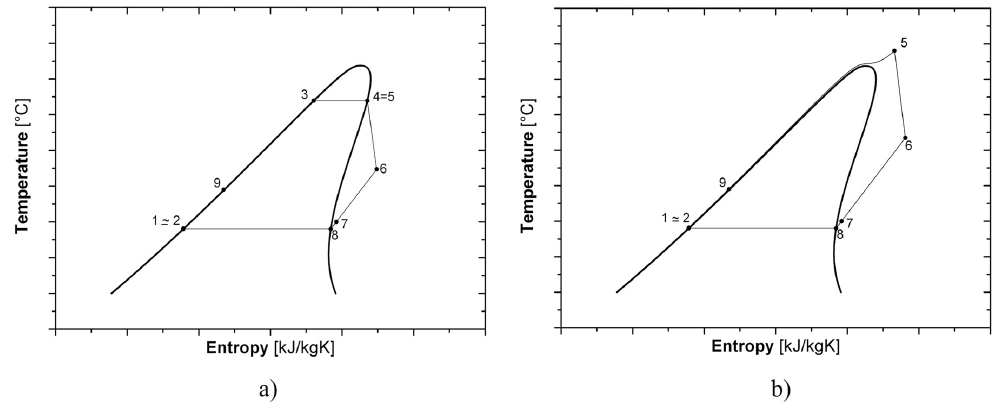
Figure 3. Subcritical ( a ) and transcritical ( b ) ORC cycle.